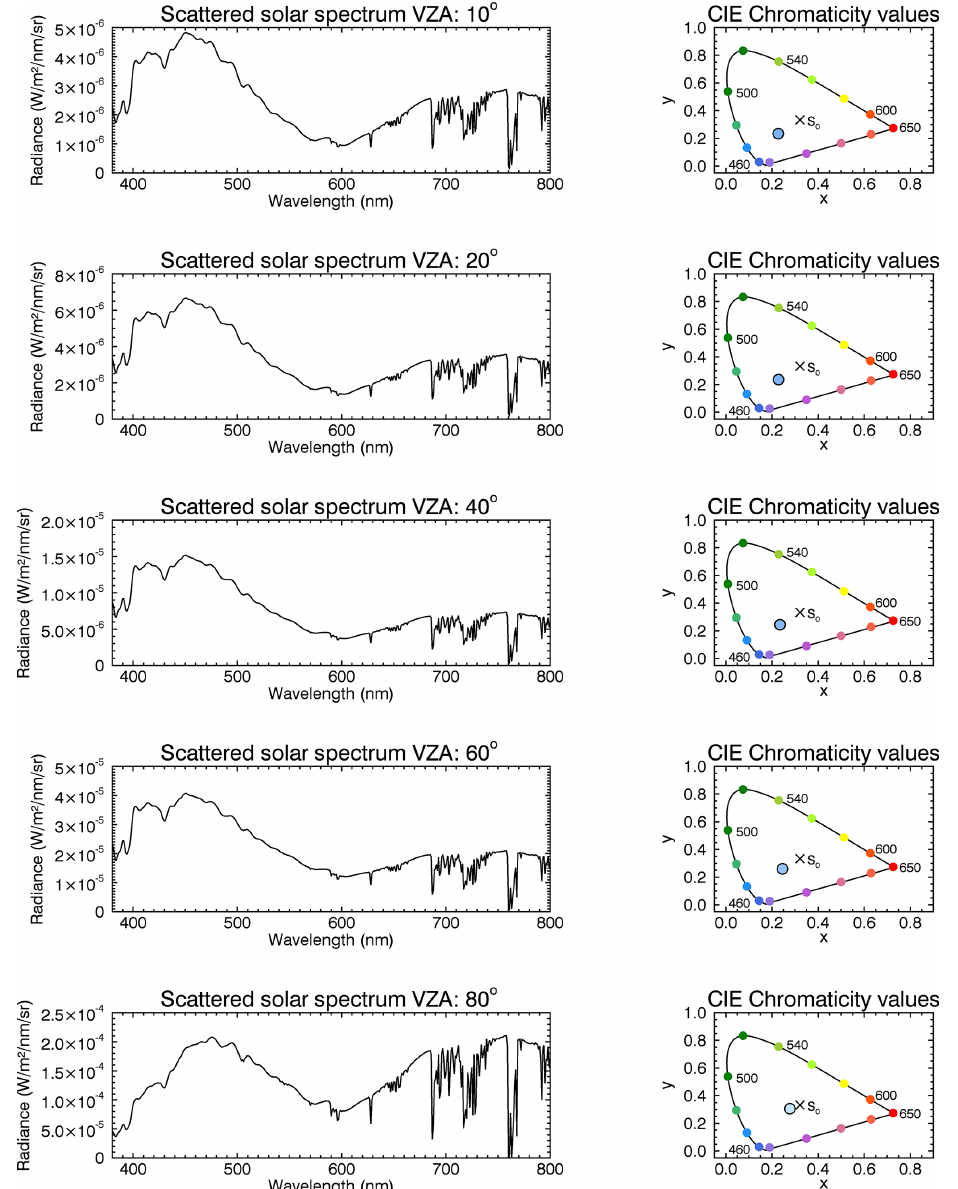
Figure 6. Solar scattering spectra (left column) and CIE chromaticity diagrams (right column) for an observer on the Earth’s surface and for a SZA of 98 ◦ and VZAs of 10, 20, 40, 60 and 80 ◦ (from top to bottom) and a SAA of 0 ◦ , including NLCs with an optical depth of 10 − 5 at an altitude of